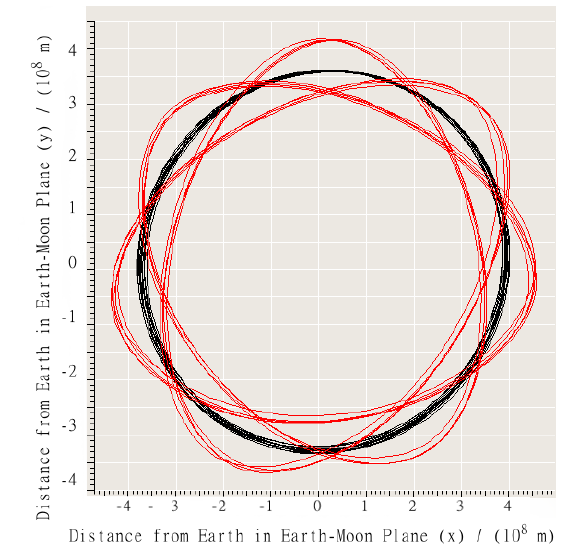
Figure 7. The 3:4:7 Resonance. The black line (circular trajectory) represents the lunar orbit, and the red line (7-pointed star) the